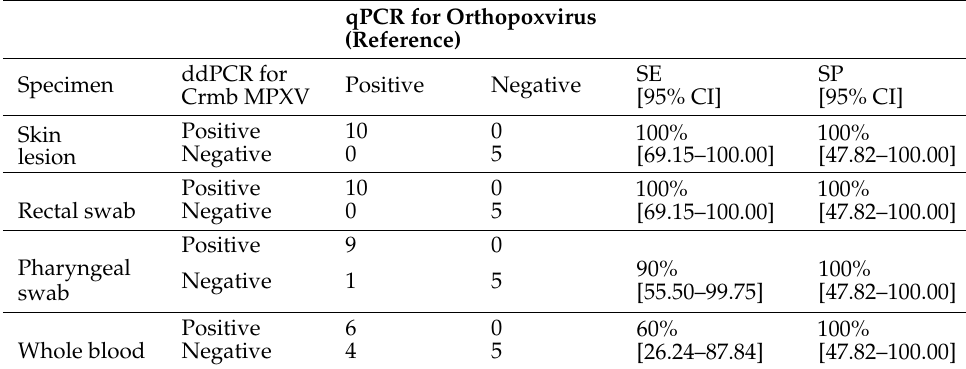
Table 1. Summarized results in the clinical samples. CI—confidence interval; SE—sensitivity; SP—